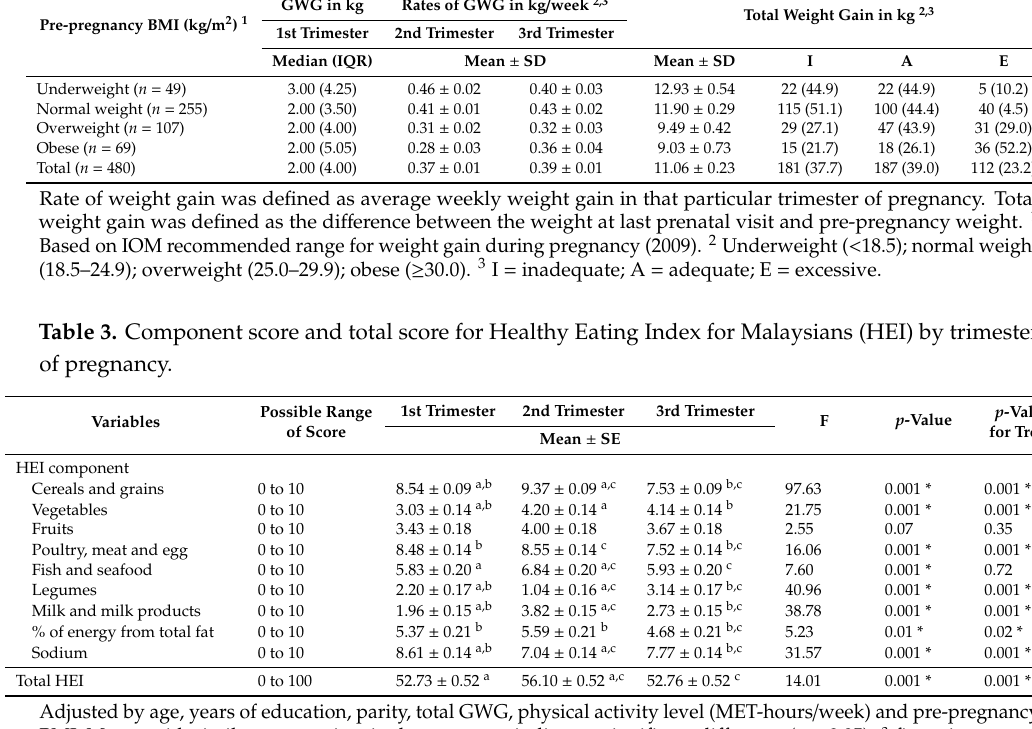
Table 2. Gestational weight gain (GWG) of women by pre-pregnancy BMI ( n = 480). Pre-pregnancy BMI (kg / m 2 ) 1